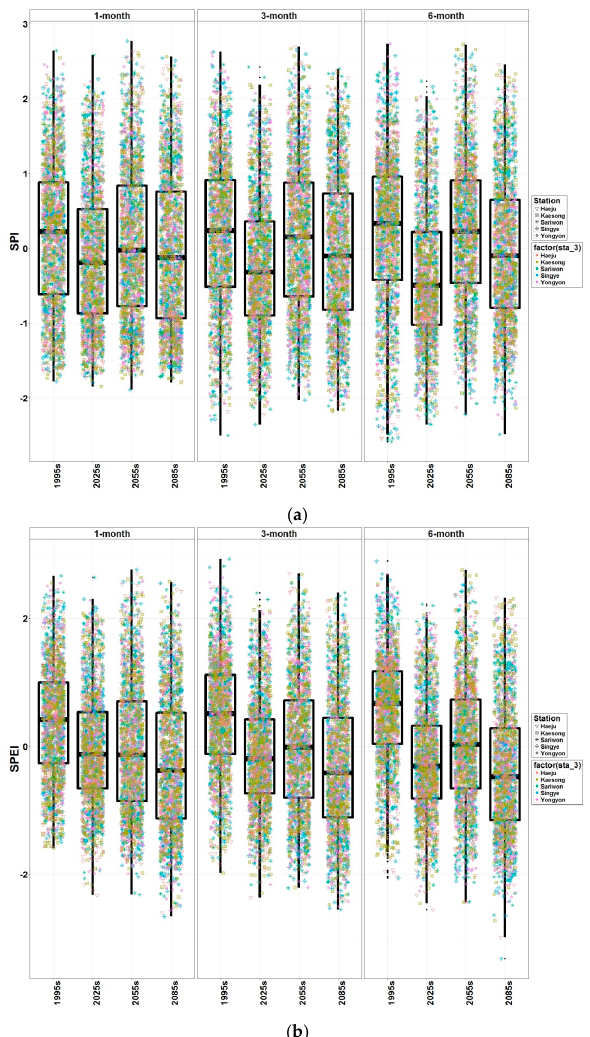
Figure 6. Boxplots of the SPI and SPEI on different timescales (one, three, and six-month) from 1981 to 2100: ( a ) SPI; ( b ) SPEI.